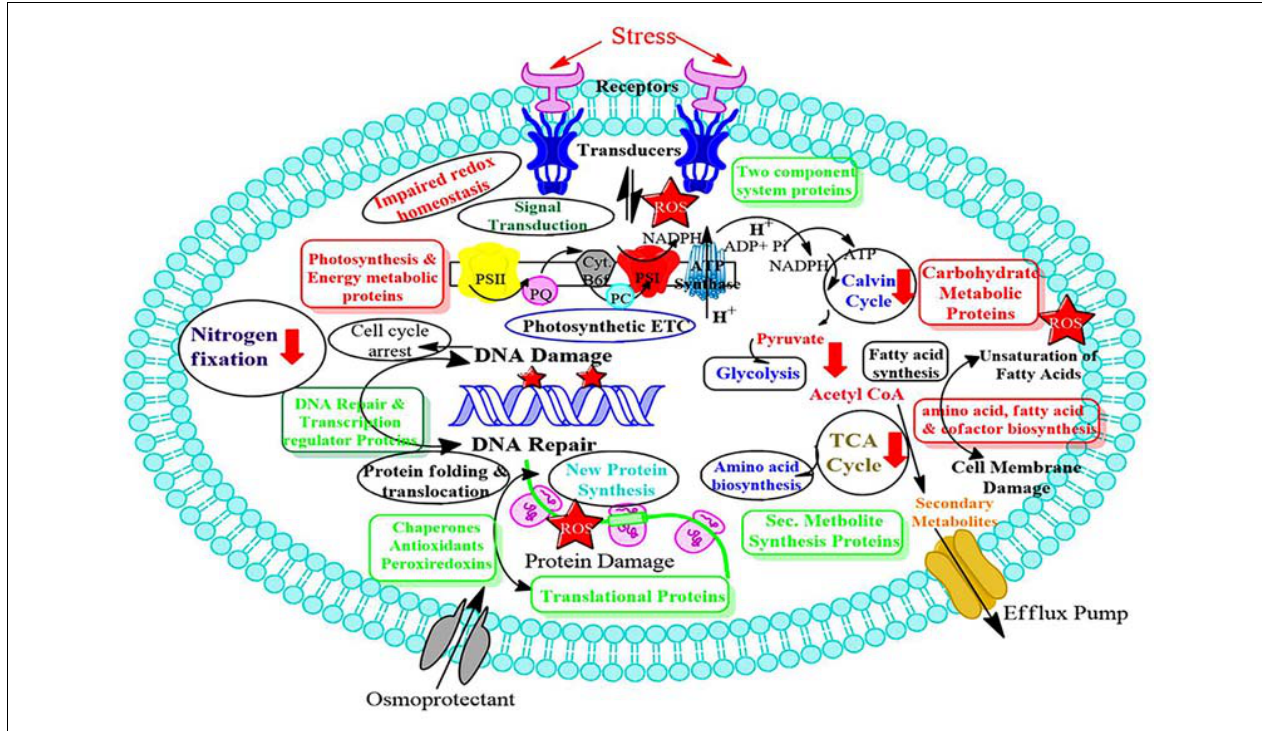
FIGURE 3 | Scheme of abiotic stress responsive protein networks involved in cyanobacteria. Proteins shown in red boxes are down regulated while proteins shown in green boxes are upregulated. Metabolic processes having red arrows are affected by abiotic